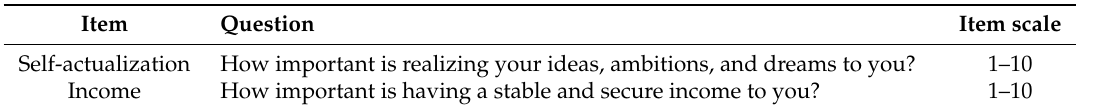
Table 4. Operationalization of the survival vs. self-expression value